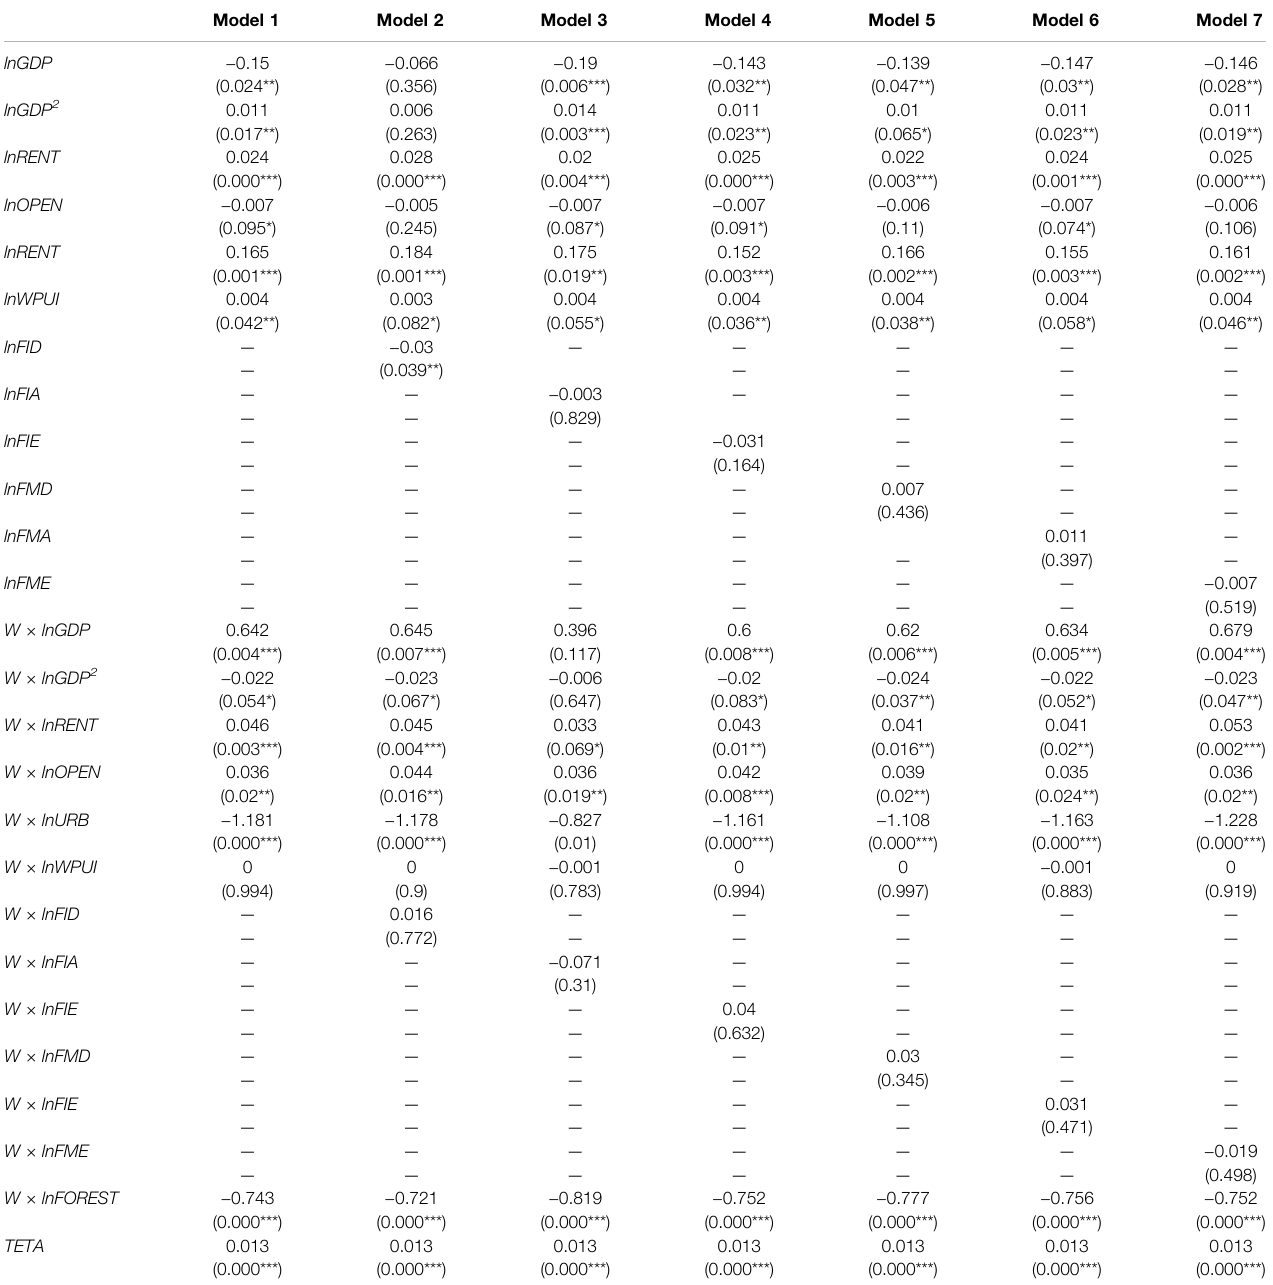
TABLE 5 | The estimation results for the spatial durbin